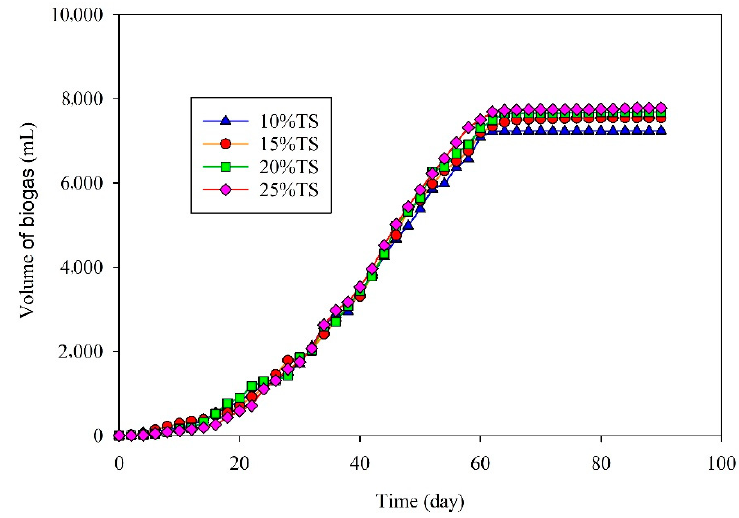
Figure 5. Effect of different percentages of total solids (TS) on nondelignified 25 (g/g) C/N ratio biogas volume accumulation.